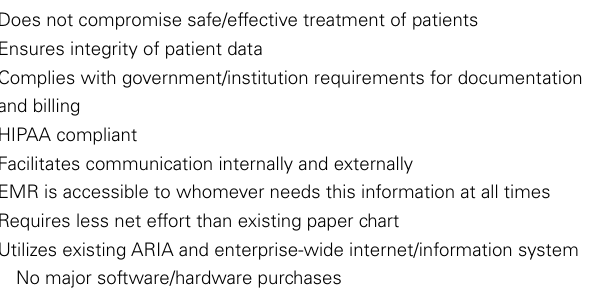
Table 2 | Required attributes for the radiation oncology EMR.